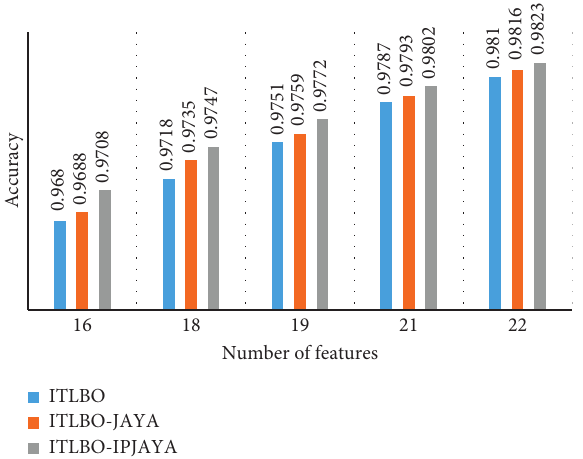
Figure 12: Accuracy based on the number of features for the NSL-KDD